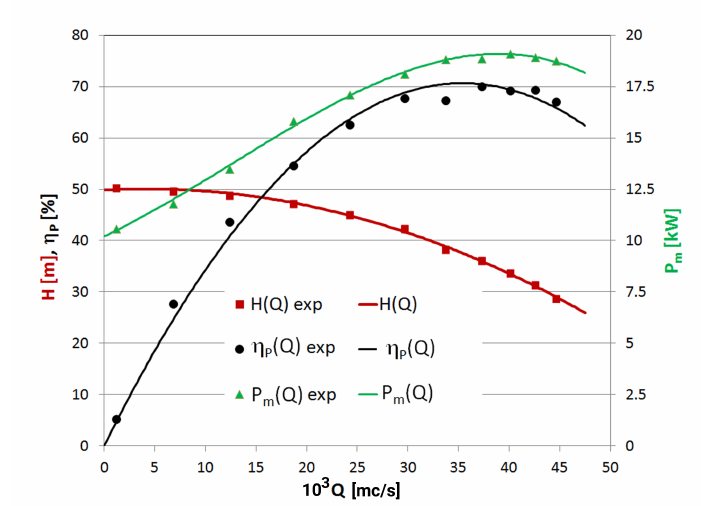
Figure 6. The experimental data for pumping head H = f ( Q ) ( (cid:4) ), mechanical power at the pump shaft P m = f ( Q ) ( (cid:78) ) and pump efficiency η P = f ( Q ) ( • ) at speed of 2900 rpm, together with polynomial curve fittings (solid